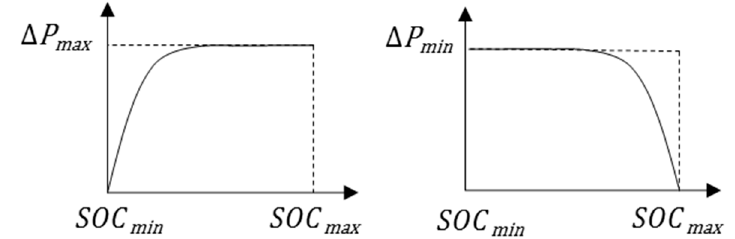
Figure 11. Active power injection limited by the SOC.